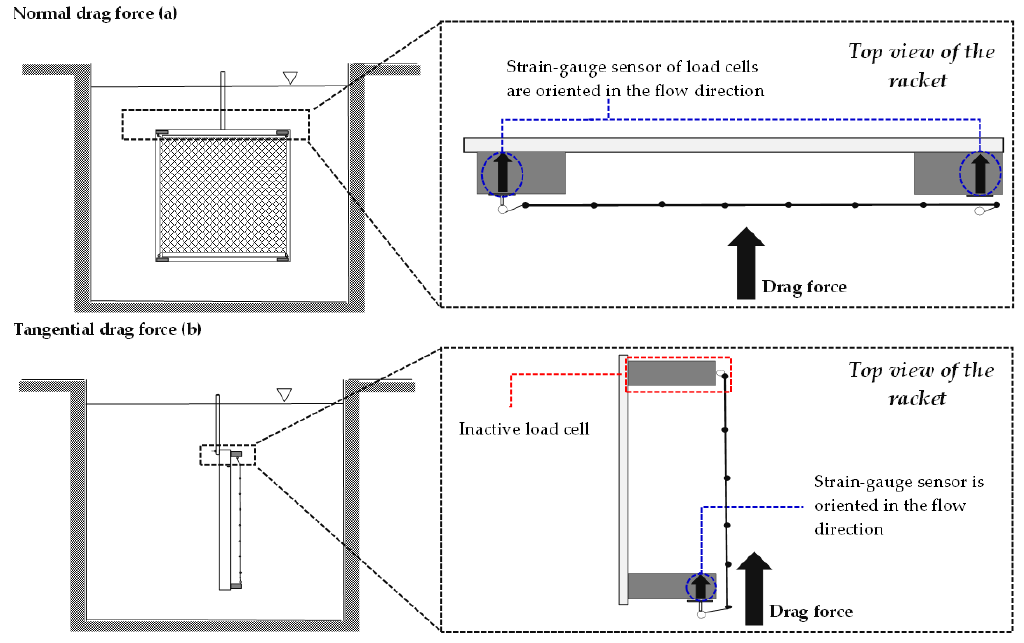
Figure 3. Frontal and top view of the experimental facility to measure the ( a ) normal drag force and ( b ) tangential drag force. A zoom-in of the top of the racket is included, to illustrate the load cells’ configurations for the normal and tangential experiments.